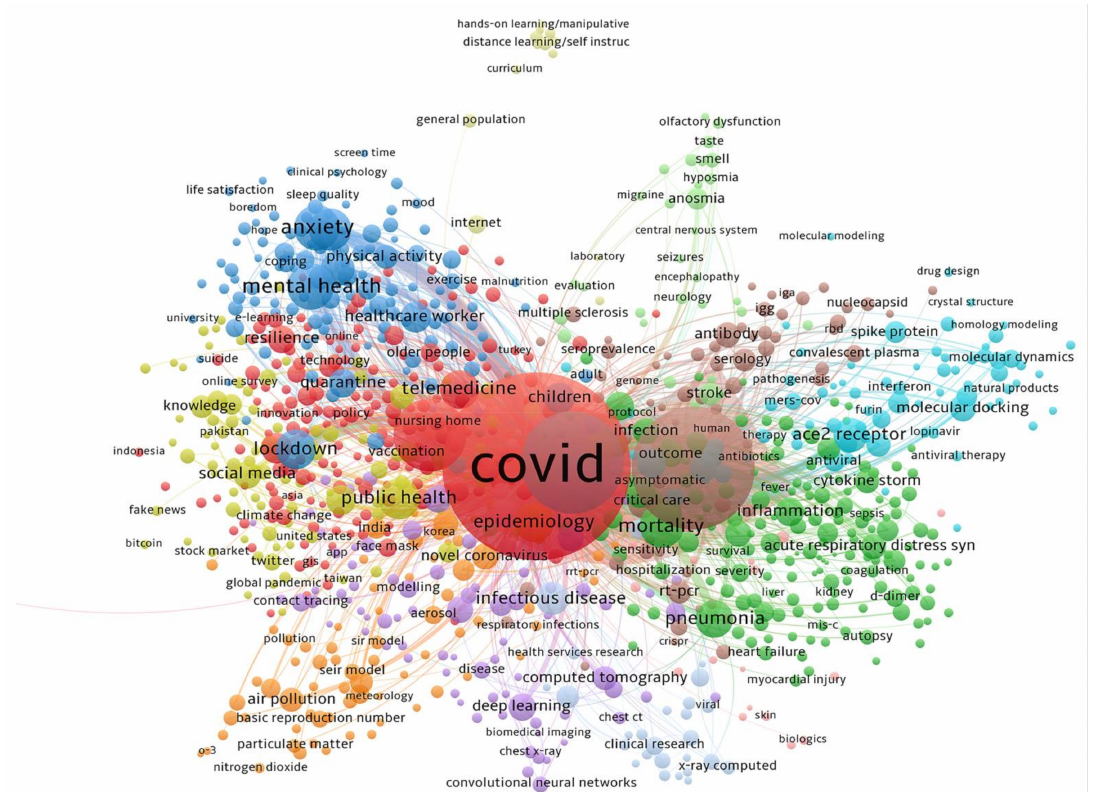
Figure 5. Map of co-occurrence after searching for the terms COVID-19 or